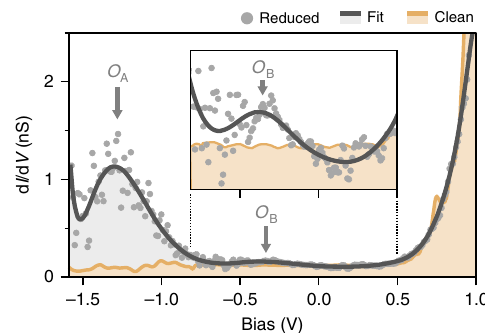
Fig. 2 Dissipation peak formation upon high-temperature annealing of reduced STO. Bias voltage dependence of friction coef fi cient Γ between the metallic tip oscillating with amplitude A = 1 nm and SrTiO 3 (100) sample annealed at two different temperatures of 850 °C (black) and 950 °C (blue). Higher annealing temperatures (characterised by reconstruction) lead to larger dissipation and pronounced dissipation peaks marked by arrows. Additional grey axis on the left and pale-blue axis on the right give corresponding per-cycle energy dissipation values P [eV/cycle] (see “ Method ” section for details)